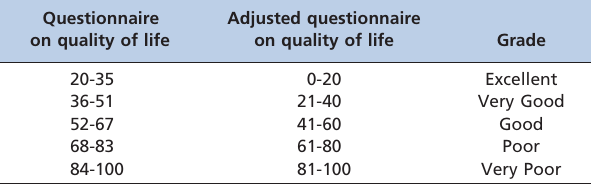
Table 1 - Grades and values for the adjusted questionnaire on quality of life.